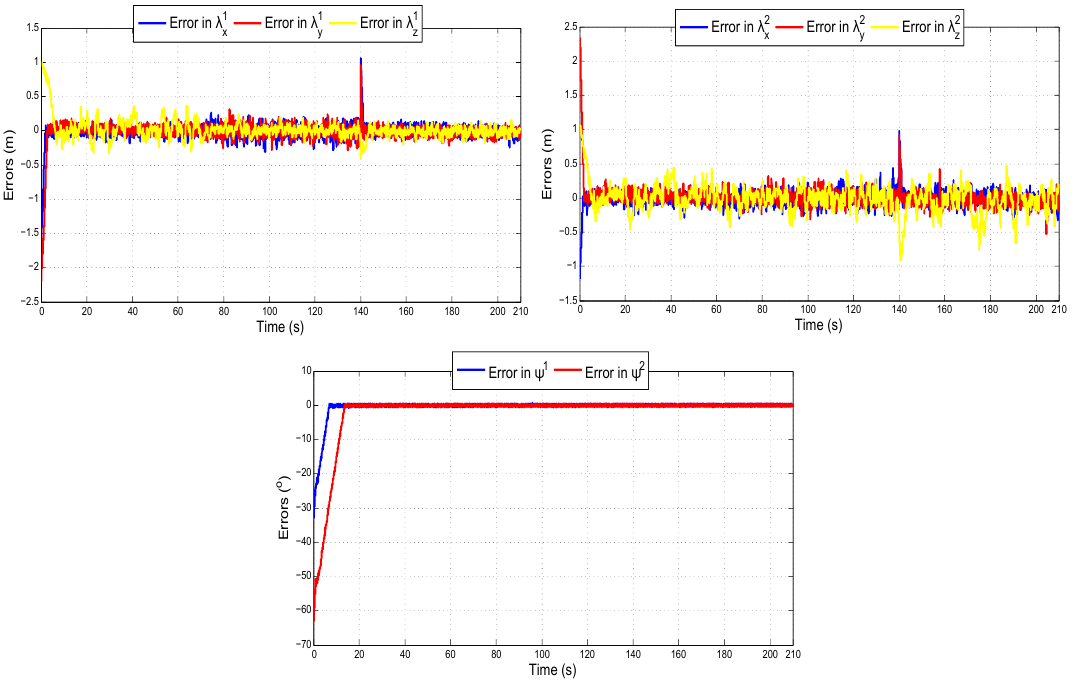
Figure 14. Errors in λ d during the flight